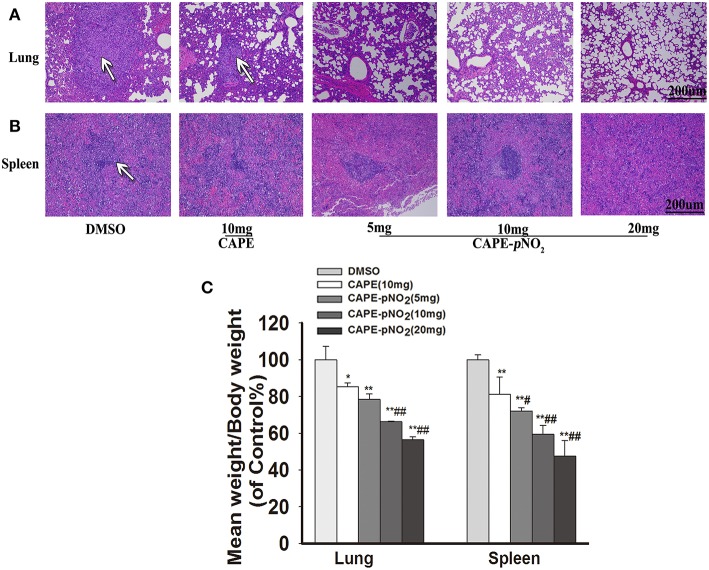
CAPE-pNO2 attenuated pulmonary and splenic metastatic tumor cells. (A,B) the tumor metastatic nodules (White arrows) in organs analyzed by HE staining. (C) The weights of the removed lungs and spleens of xenograft mice after treatment (n = 6). Values represent the mean ± SD from three independent experiments; *p < 0.05, **p < 0.01: CAPE and CAPE-pNO2 compared with DMSO group; #p < 0.05, ##p < 0.01: CAPE-pNO2 (5, 10 and 20 mg/kg) compared with CAPE (10 mg/kg).